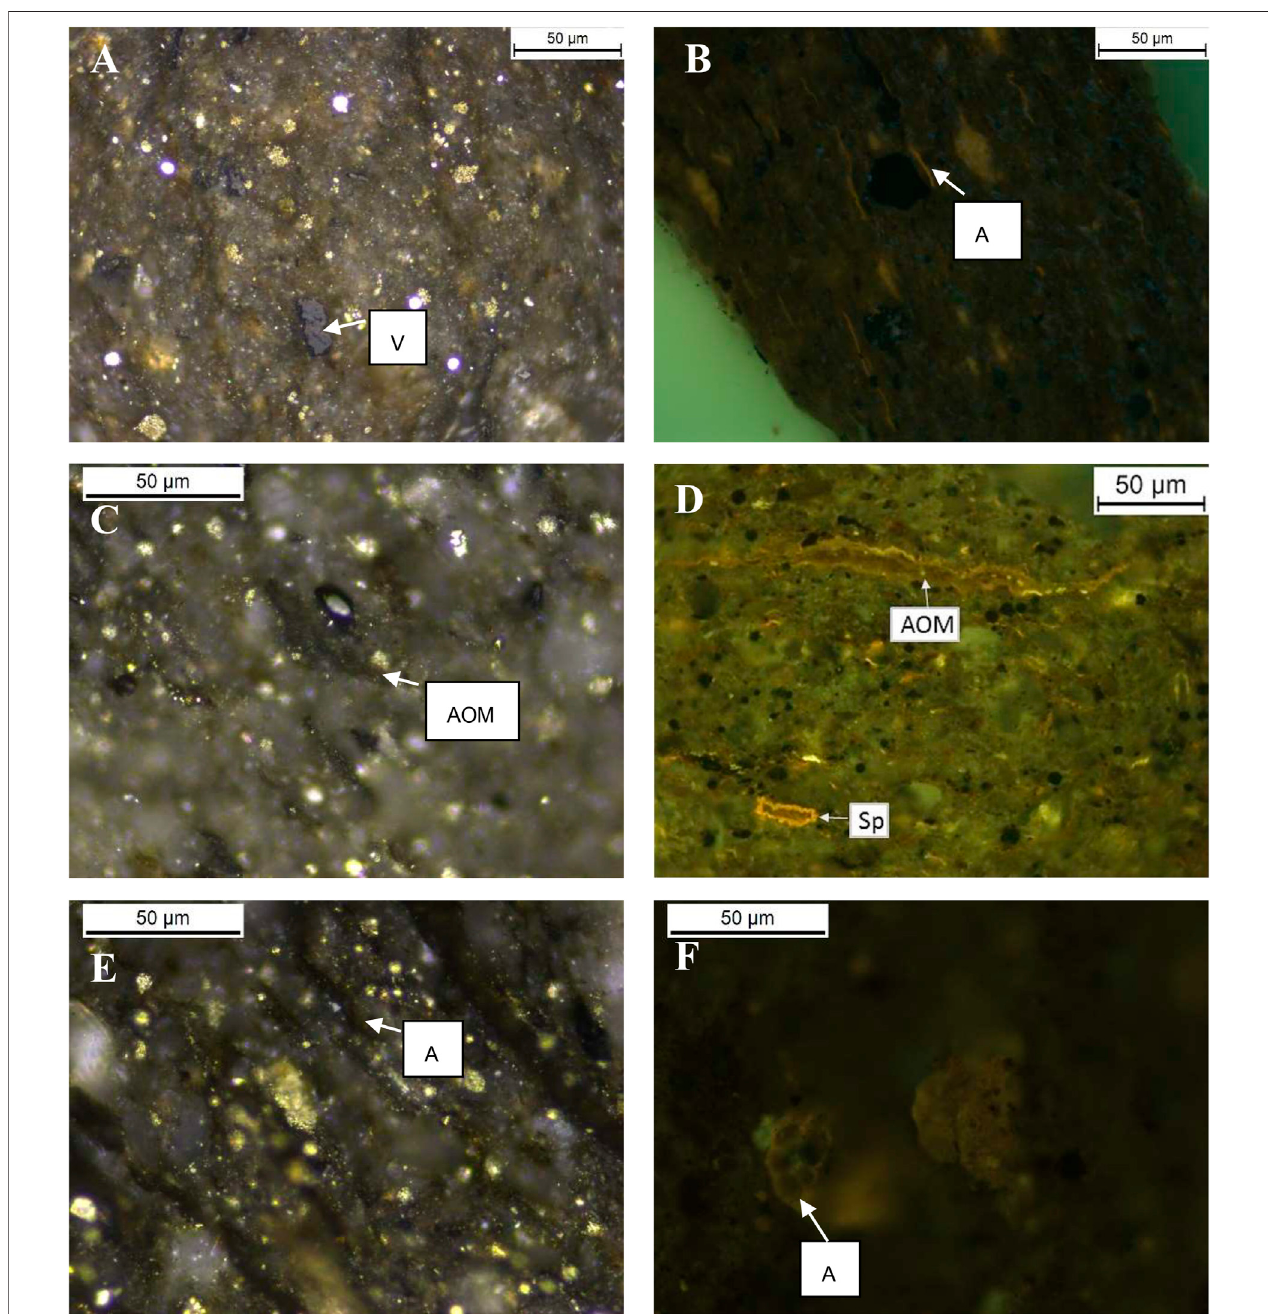
FIGURE 5 | Representative photomicrographs of macerals observed in polished blocks under re fl ected white and fl uorescent light with an optical microscope using oil immersion. The selected pictures represent the typical type and quality of organic matter found in studied source rocks. Panels (A,B) were taken on samples from Mowry Shale. Most of the organic matter is composed of alginite and amorphous organic matter. Mowry also contains a certain amount of vitrinite and inertinite macerals.Panels (C – F) weretakenonsamplesfromSecondWhiteSpecksFormation,whicharemainlycomposedofbothamorphousorganicmatterandalginite. Panel (D) was adopted from Furmann et al. (2015). Panel (E) shows the typical presence of Lamalginite, and Panel (F) shows the typical presence of Telalginite. Abbreviations: V – vitrinite, AOM – amorphous organic matter, Sp – sporinite, A – alginite, I – inertinite, Lpd – liptodetrinite.